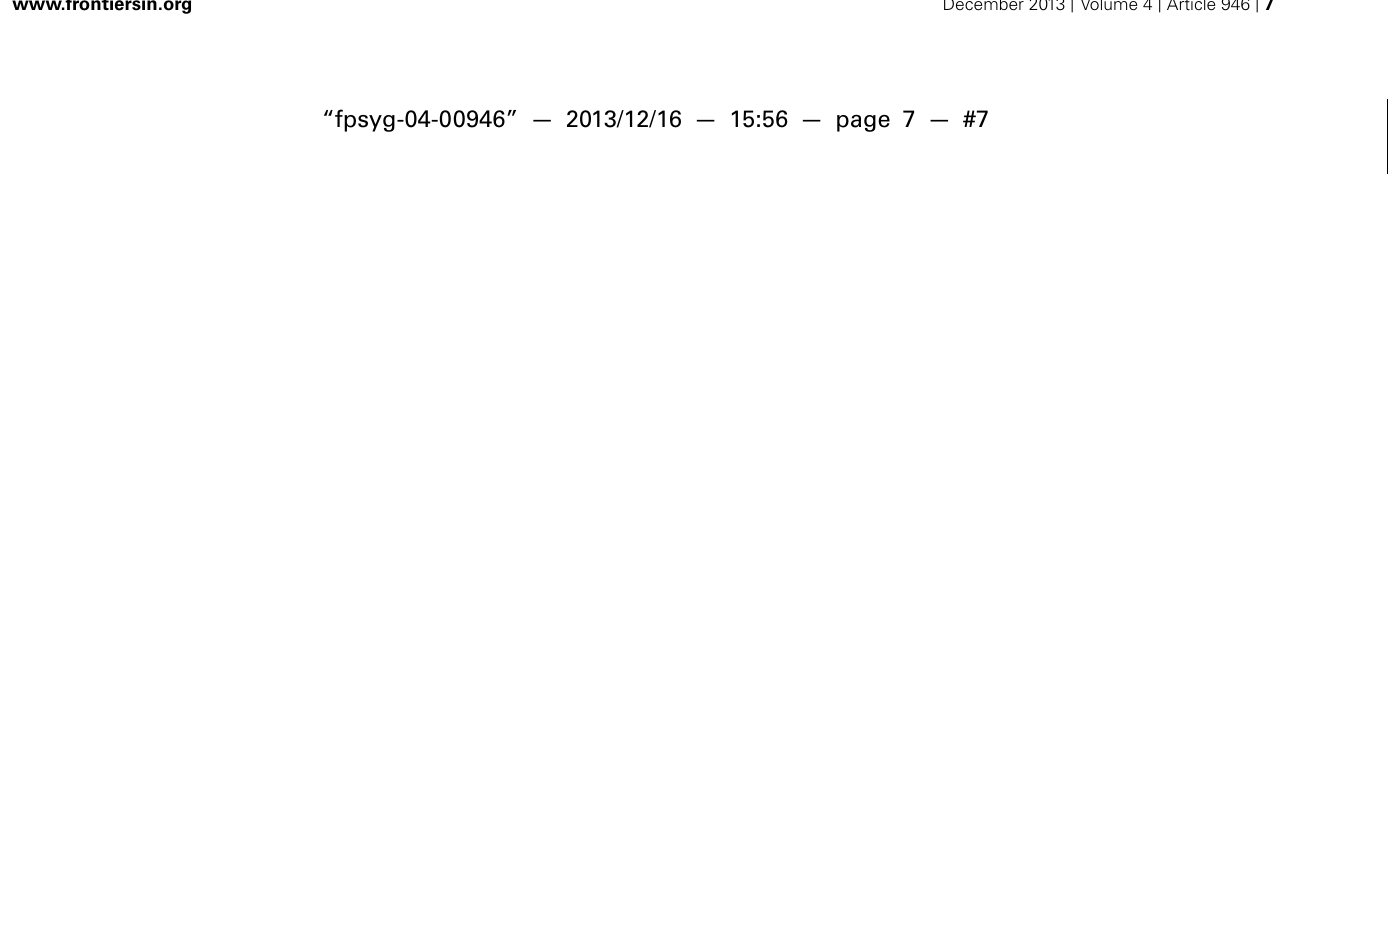
FIGURE 4 | Drift results for Study 1 and Study 2. This figure shows the mean drift for BS, BA, OS, and OA for study 1 and study 2. Error bars represent one standard error of the mean. Asterisks indicate a significant difference based on pairwise comparisons. Note: the overall